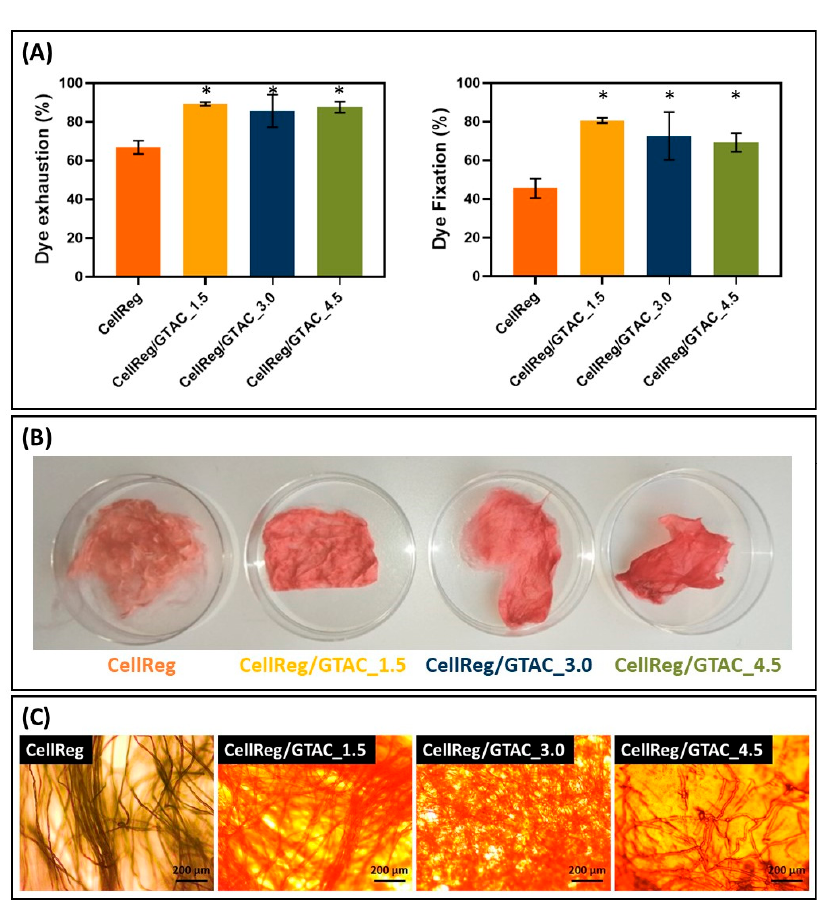
Figure 4. ( A ) Dye exhaustion and dye fixation for the fiber samples: CellReg, CellReg/GTAC_1.5, CellReg/GTAC_3.0 and CellReg/GTAC_4.5 (the symbol * denotes the means with a significant difference from the CellReg sample at p < 0.05), ( B ) digital photographs and ( C ) optical micrographs of the fiber samples after the dyeing uptake